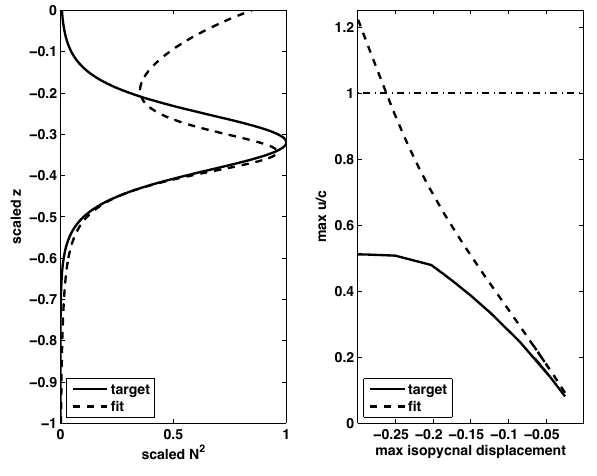
Fig. 2. Left Panel: The scaled N 2 (z) profiles for the two profiles that yield nearly identical coefficients in the KdV theory. Right Panel: The ratio of maximum wave-induced horizontal velocity to the wave propagation speed as a function of dimensionless isopyc- nal displacement for the two cases shown in the Left Panel. Waves break when u/c exceeds one (the dot-dashed, horizontal